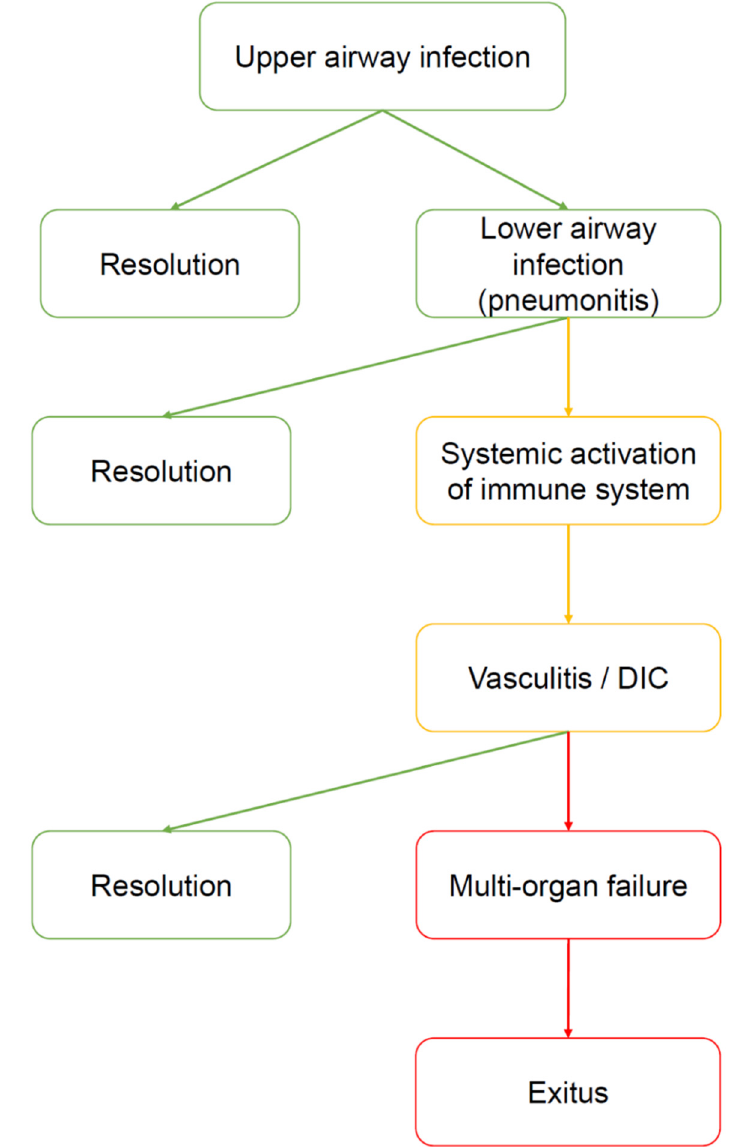
Figure 2. Natural history of COVID-19. The virus enters by the upper airways (nasal cavities). At this stage, the disease can be asymptomatic, paucisymptomatic or produce symptoms such as fever, cough, anosmia, ageusia, and shortness of breath. Many subjects heal spontaneously. However, in a limited number of subjects the virus moves down to the lower airways, causing severe pneumonia. It is not clear why some patients develop pneumonia and other do not. However, cold weather, high humidity, and severe pollution can be considered prodisease factors because they may favor virus vitality outside the body and inflammatory status inside the airways. Most of the patients with pneumonia manage to heal (for example, by ex juvantibus therapies, such as tocilizumab or hydroxychloroquine), however, some of them develop severe complications, i.e., a generalized activation of the immune system manifested as vasculitis, disseminated intravascular coagulation (DIC), and other signs and symptoms of autoimmunity. At this point, the risk of developing a multiorgan failure (MOF) is high, and the patient may